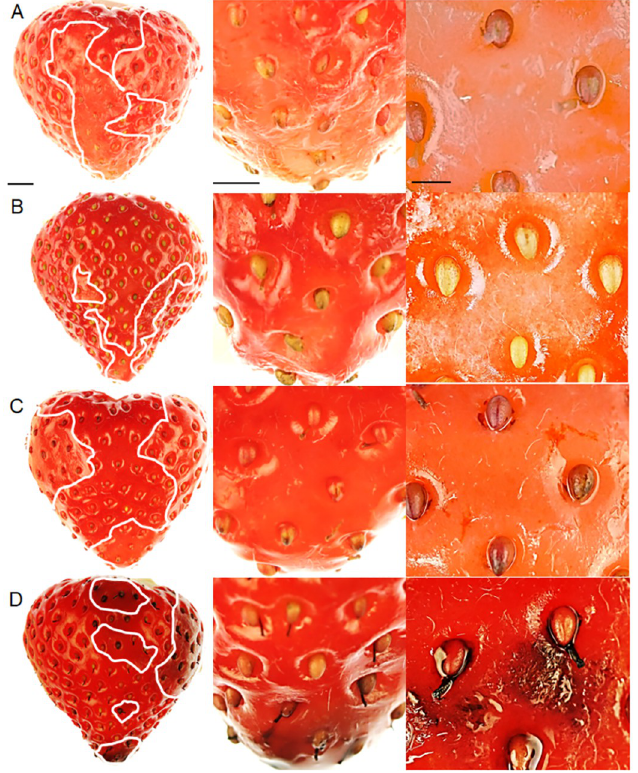
Fig 5. Water soaking of fruit incubated in (A) deionized water, (B) CaCl 2 , (C) CuCl 2 , and (D) FeCl 3 . The white line indicates the extent of the water-soaked area. Scale bar in A = 5 mm (top row), 2 mm (center row), 1 mm (bottom row).